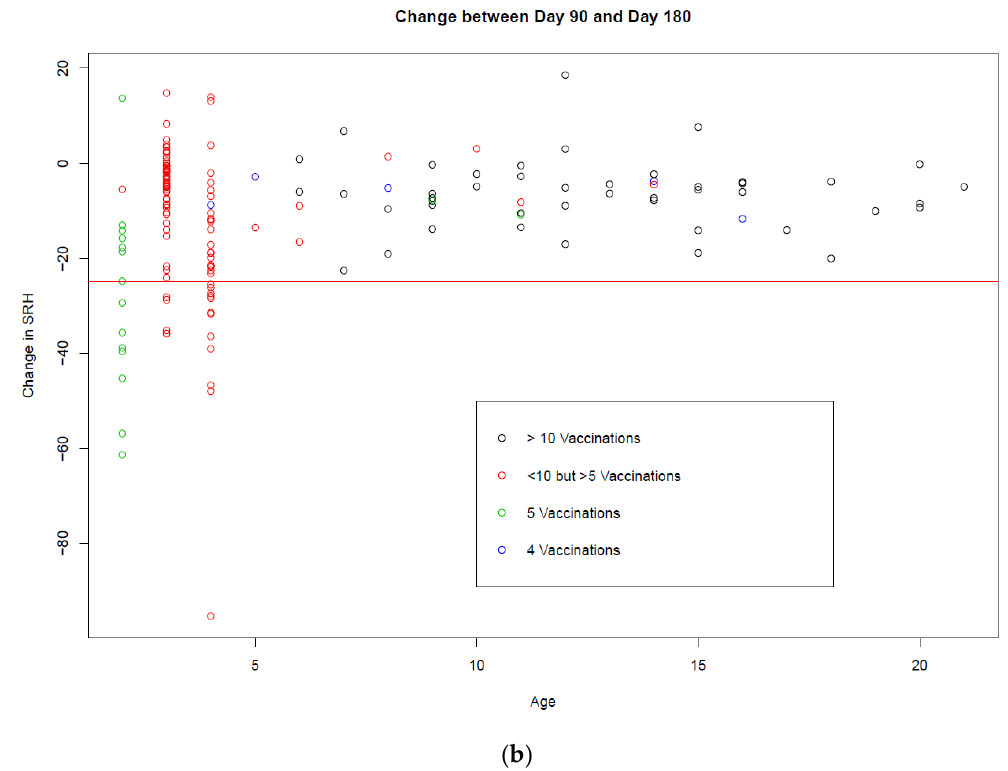
Figure 6. The change in SRH antibody titres between days 60 and 90 ( n = 216) and days 90 and 180 ( n = 160) by age is represented in ( a ) and ( b ), respectively. The black circles represent the horses that received >10 doses of vaccine, the red circles represent the horses that received <10 but >5 doses of vaccine, the green circles represent horses that received five doses of vaccine, and the blue circles represent horses that received four doses of vaccine. The red horizontal line is drawn at −25 mm 2 , as a decrease of ≥25 mm 2 is considered significant.